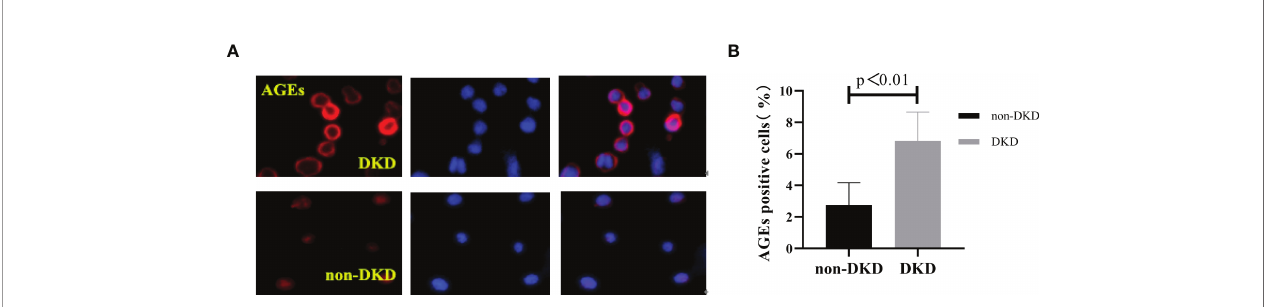
FIGURE 1 | The number of age-positive cells in PBMCs of T2DM patients with DKD was higher than that of T2DM patients without DKD. (A) Immuno fl uorescence; Red: the age-positive cells; Blue: DAPI staining the nucleus. (B) The comparison of age-positive cells in PBMCs of T2DM patients with DKD and that of T2DM patients without DKD.